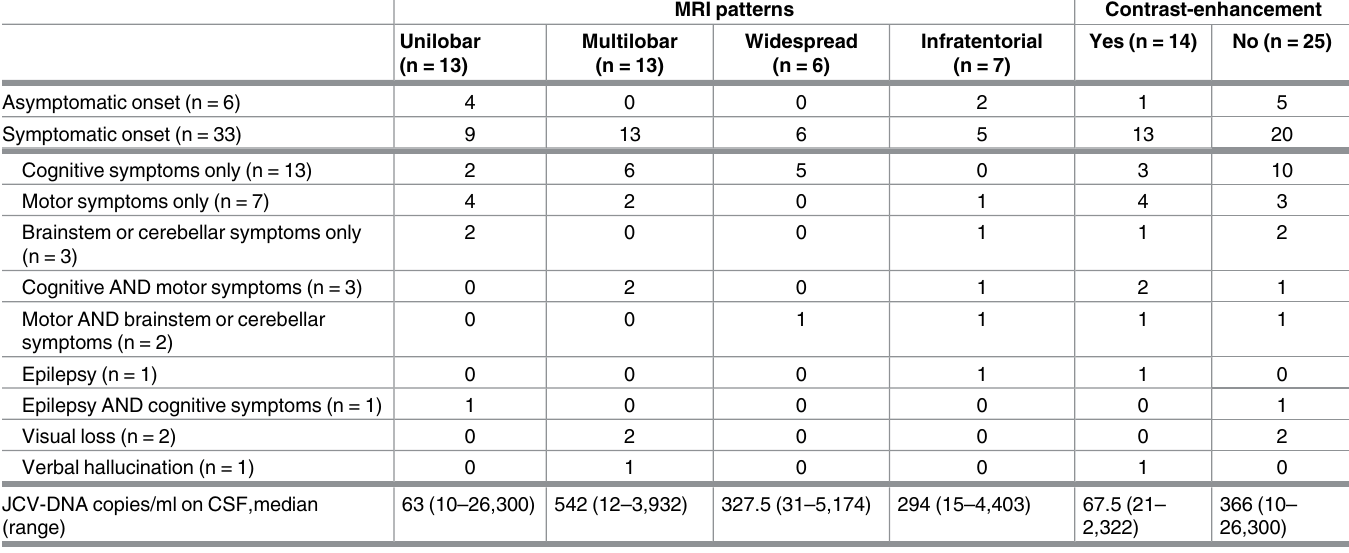
Table 2. Relationships between MRI featuresand clinical and laboratory findings at PML onset. MRI patterns